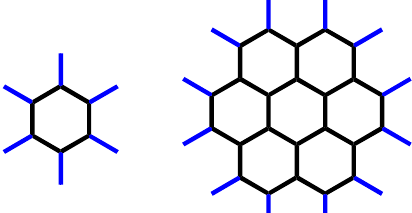
Fig. 6. The first and second member of polycyclic aromatic hydrocarbon PAH